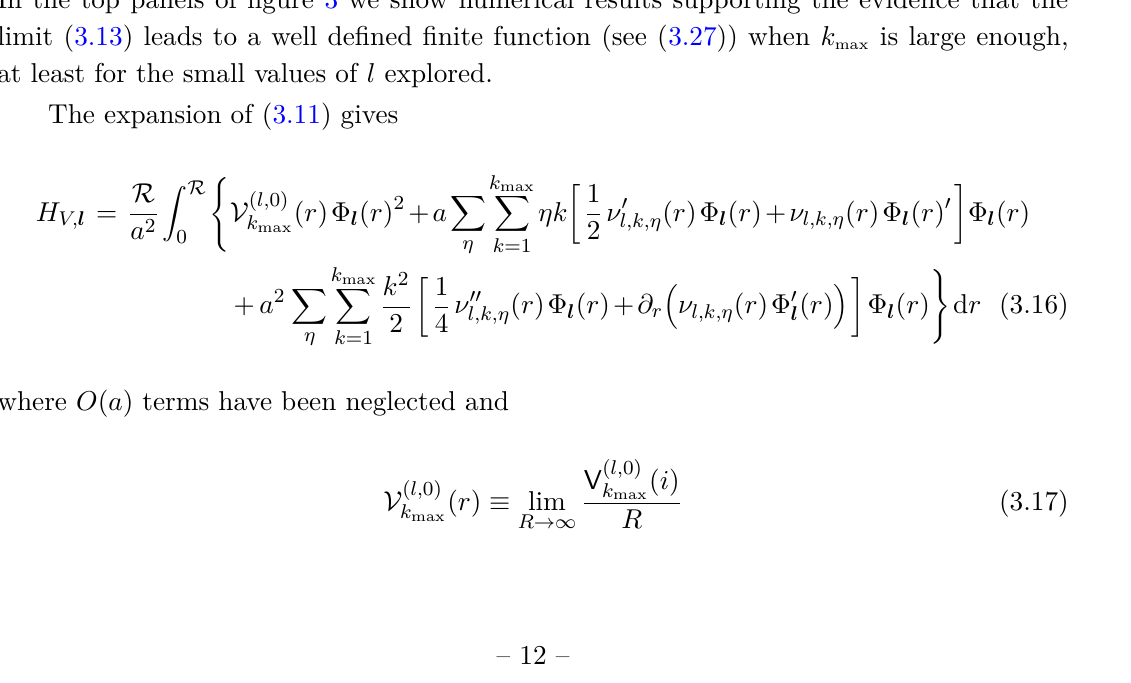
Figure 3. T ( l, 0) /R from (3.14) (top panels) and − V ( l, 2) /R from (3.21) (bottom panels), when k max k max ω = 0 and either d = 2 (left panels) or d = 3 (right panels), for small values of l and k for every l (other choices for k have been considered in figure 14). The red curve corresponds to max the CFT prediction